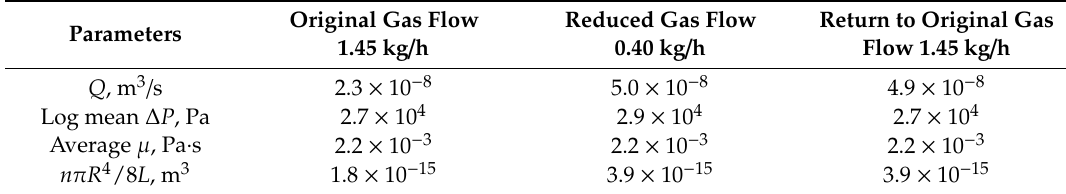
Table 4. Changes in the degree of membrane wetting when feed gas flow rate was reduced.